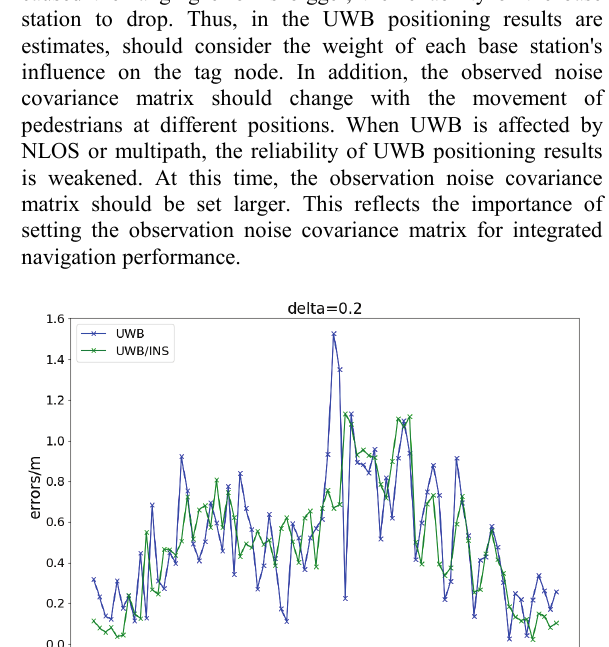
Figure 9 . Comparison of the positioning error of UWB and the positioning error of UWB/INS integration when ( are the diagonal elements of the observation noise covariance matrix).